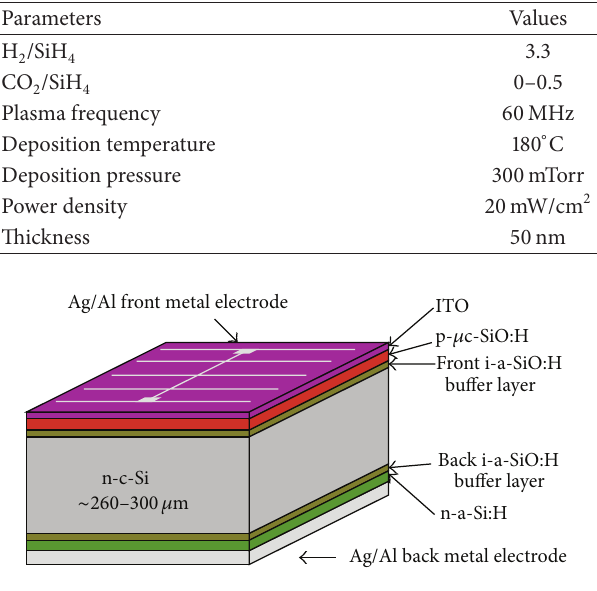
Figure 1: Schematic diagram of c-Si-HJ solar